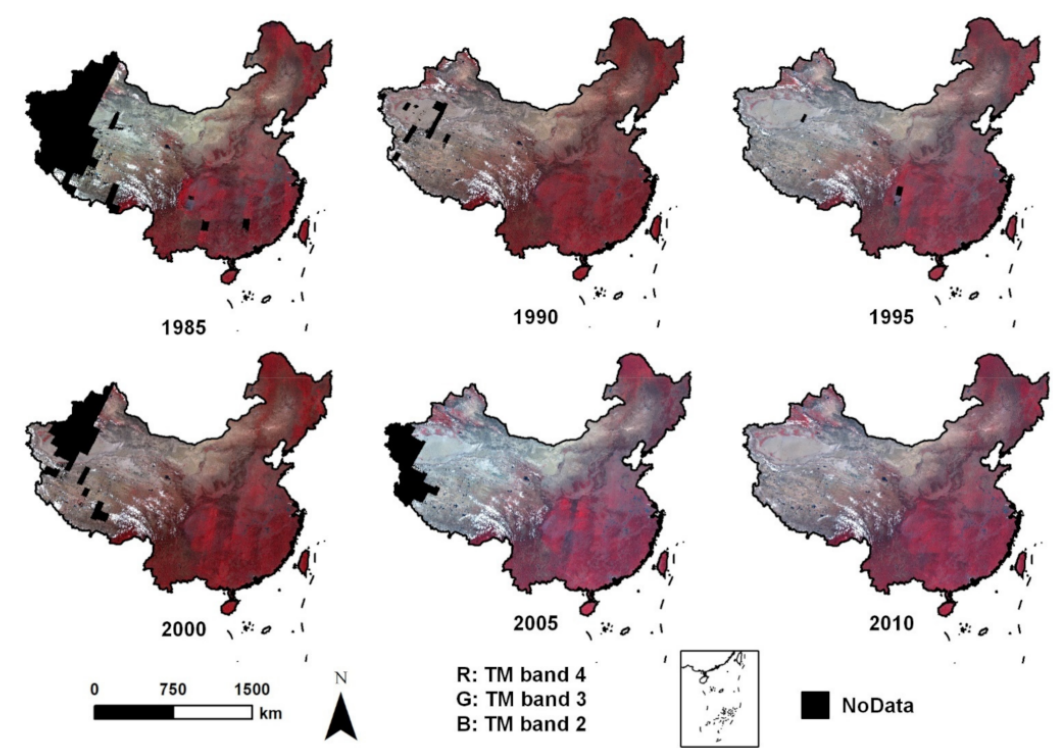
Figure 4. Cloud-free Landsat-5 composites of China from 1985 to 2010.